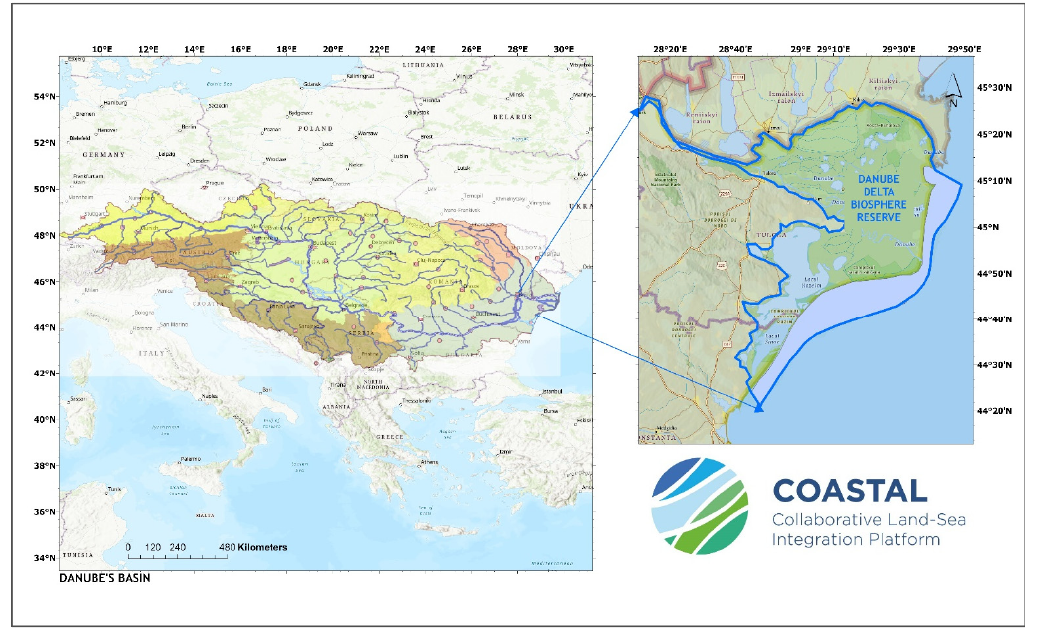
Figure 1. Map of the region (Danube’s basin) and the studied area (Danube Delta).